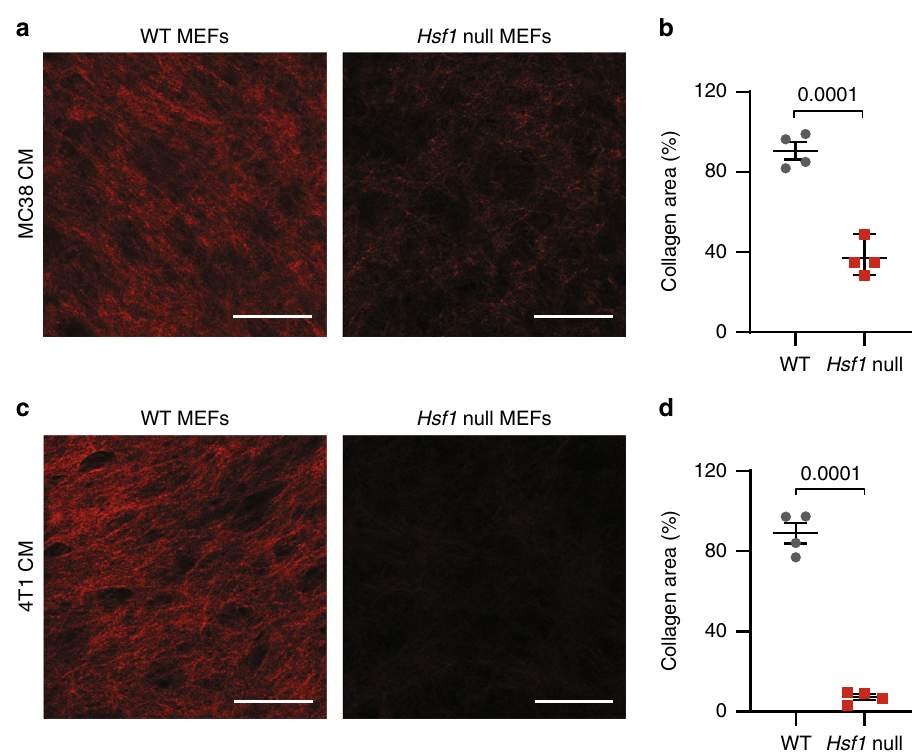
Fig. 1 Loss of HSF1 impedes fi brillar collagen deposition by fi broblasts. WT or Hsf1 null immortalized MEFs were induced to secrete ECM by 7 days incubation with conditioned media from MC38 colon cancer cells a , b or 4T1 breast cancer cells c , d supplemented by growth factors and insulin. Representative images are shown in a , c . The average area covered by collagen in n = 4 biological independent cells, examined over four independent experiments, each with three technical replicates, is quanti fi ed in b , d . Scale bar — 50 µ m. Results are shown as mean ± SEM. P value was calculated using a two-sided unpaired Student ’ s t